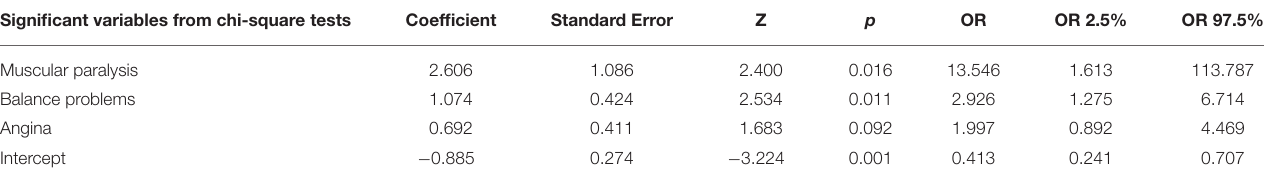
TABLE 2 | Results from the binary logistic regression for the significant variables identified from the chi-square tests with patients from the high or low depression severity categories. Significant variables from chi-square